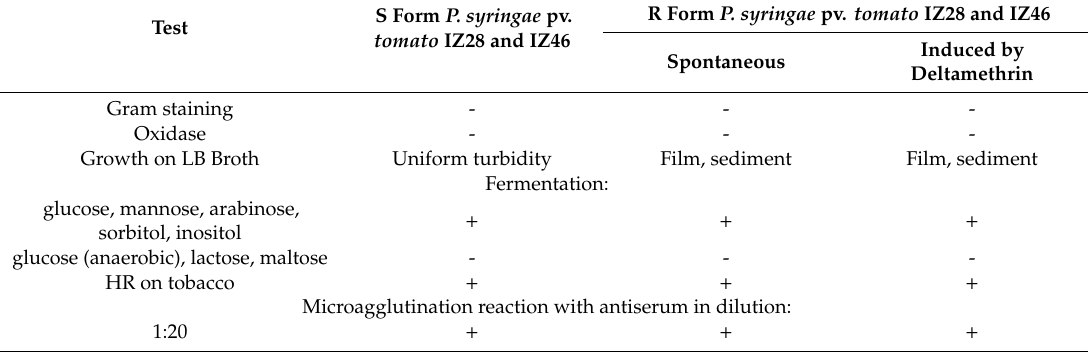
Table 4. Physiological and biochemical properties of S and R forms P. syringae pv. tomato.